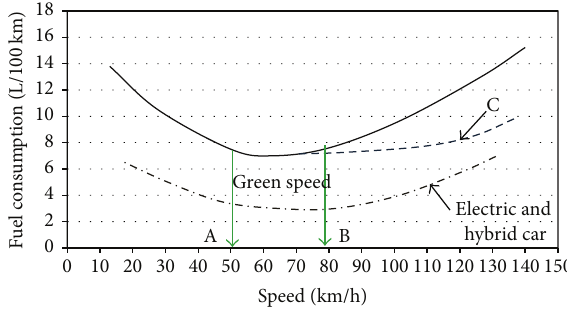
Figure 1: Relation between fuel consumption and average speed.